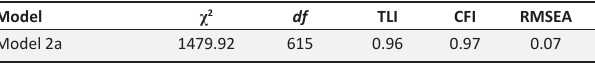
Table 2 indicates that positive leadership has statistically and practically significant correlations with all the constructs,